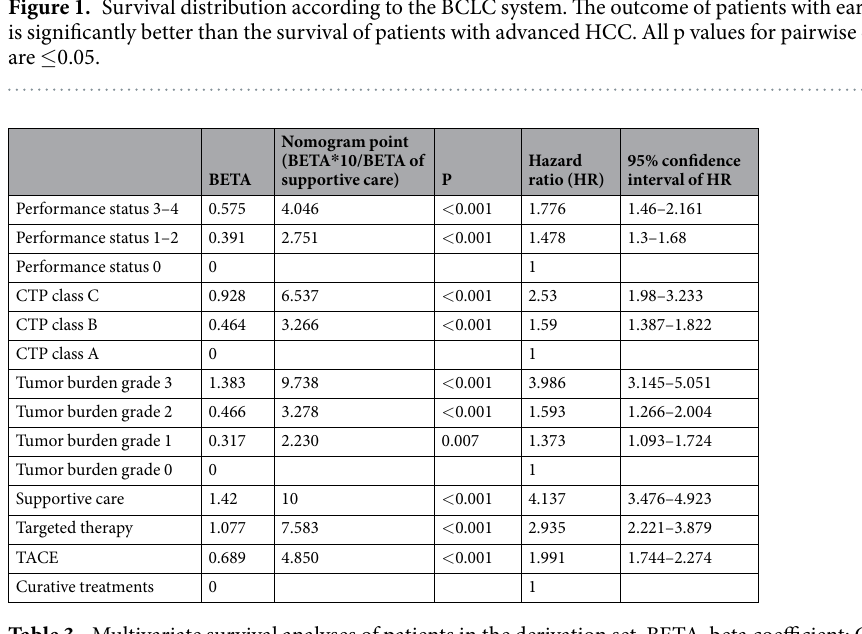
Table 3. Multivariate survival analyses of patients in the derivation set. BETA, beta coefficient; Curative treatments includes surgical resection, ablation and